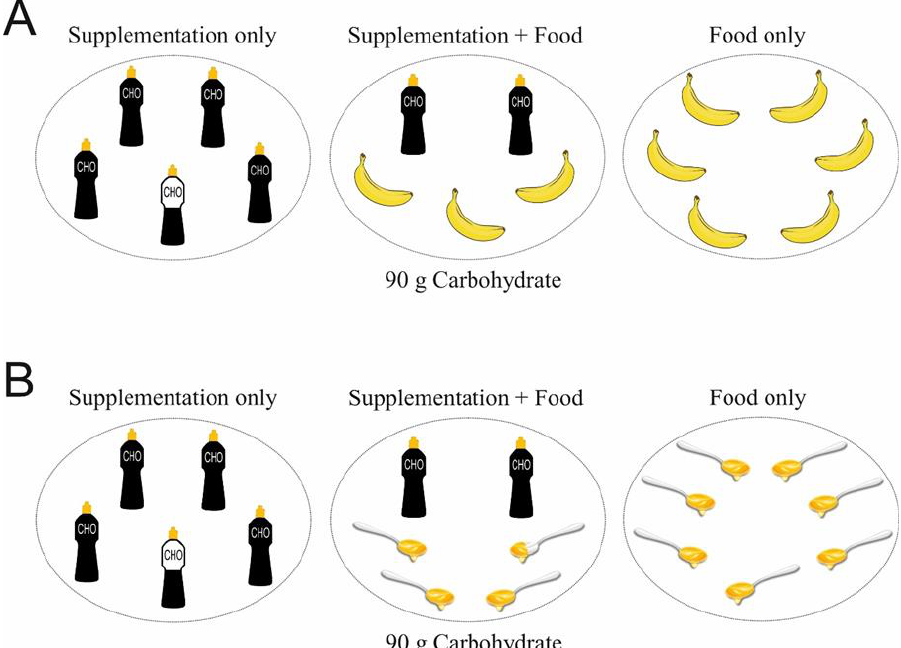
Figure 3. Examples of supplementation-only, food-only, and a combination of the two to provide 90 g · h − 1 of carbohydrate (CHO) during exercise. Athletes can choose to replace some, or all, of their supplemental CHO with food choices. Panel ( A ): Bananas. Panel ( B ): Honey .